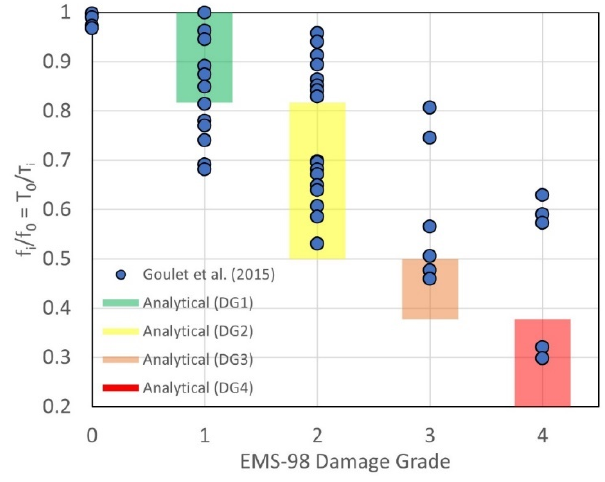
Figure 4. Overlap of the ranges of frequency reduction ( f i / f 0 ) in terms of EMS ‐ 98 DG , computed through the analytical approach ( DG 1 to DG 4) and using data points observed in [15].